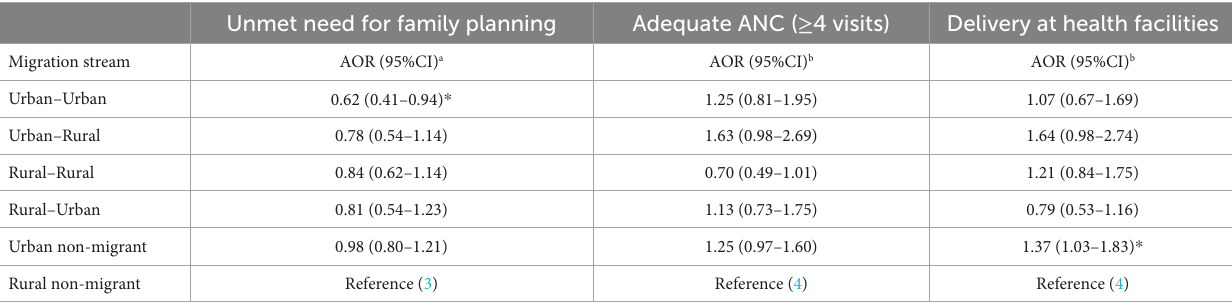
TABLE 3 Adjusted odds ratio (AOR) and 95% confidence interval (95%CI) for the association of internal migration with unmet need for family planning, adequate ANC, and delivery in health facilities among married women aged 15–49 in PDHS 2017–18. Unmet need for family